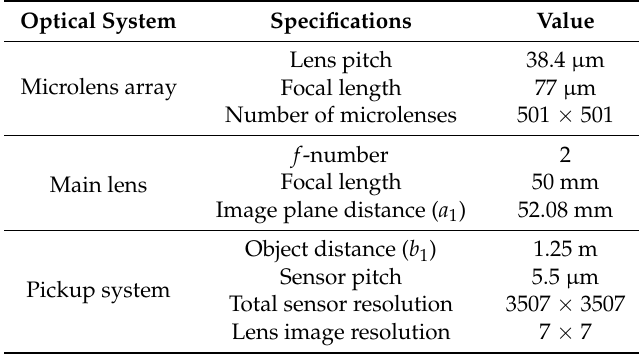
Figure 4. Depth extraction example: ( a ) Example of light field image; ( b ) magnified light field image, ( c ) depth extraction results; and, ( d ) comparison of the ground truth and extracted depth maps obtained by InIm method and light field camera (LFC) method. Table 1. Specification for simulation and experiments.